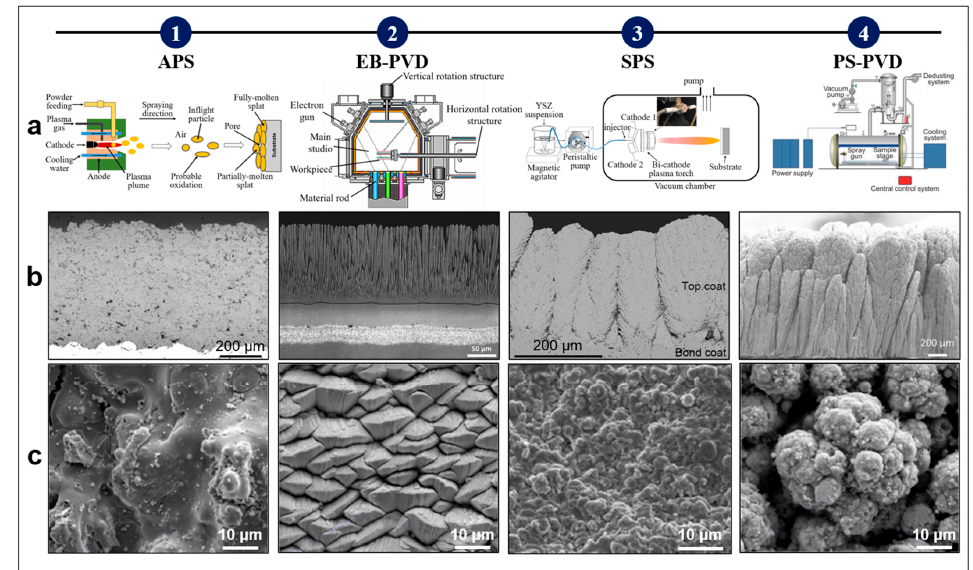
Figure 2. Schematic diagram of the preparation process of TBCs: ( a ) equipment working principle ( b ) cross-section ( c ) surface SEM images (adapted from [33–40] ).